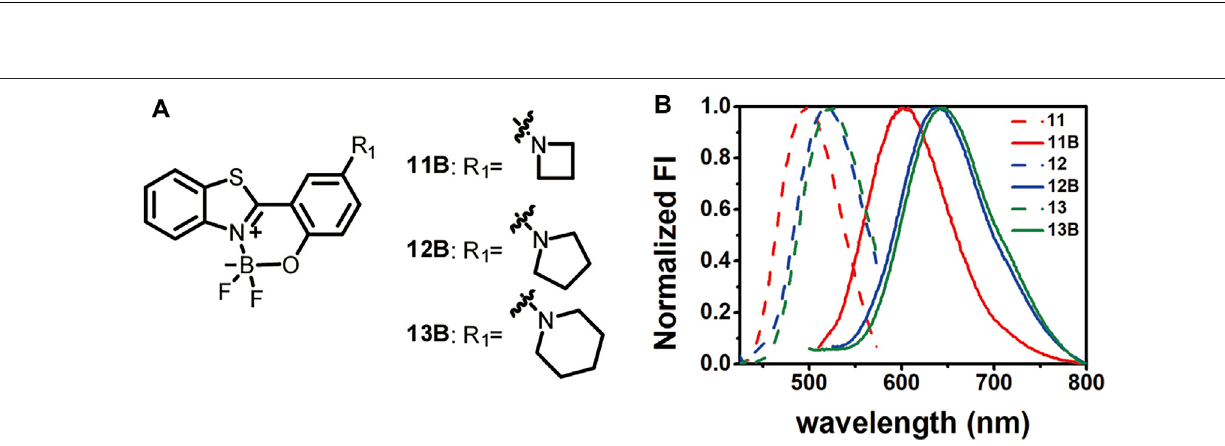
Frontiers in Chemistry |